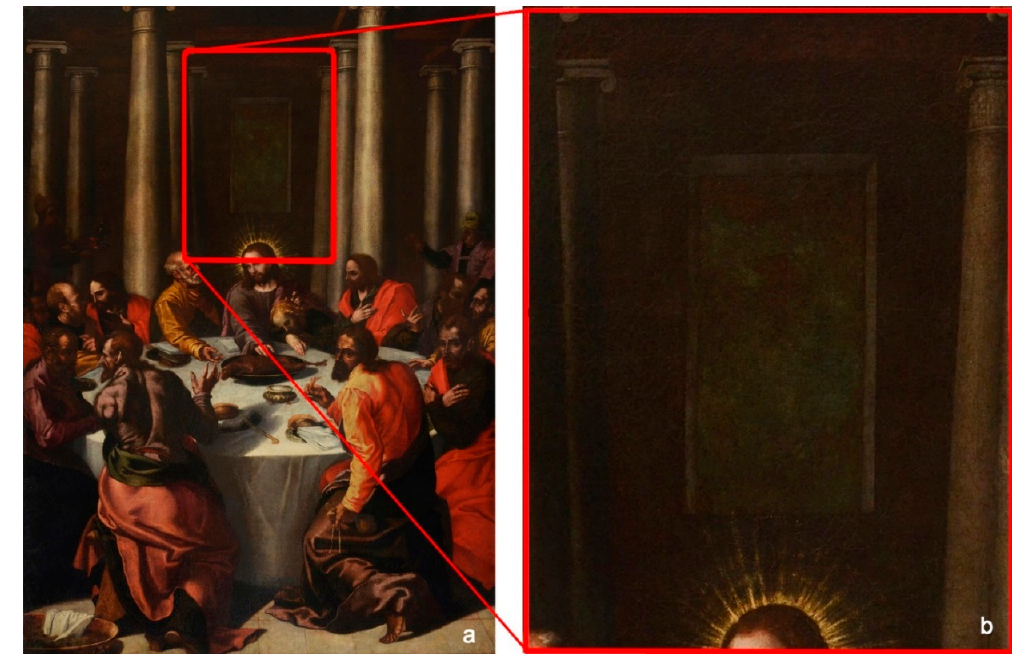
Figure 18. ( a ) G. Hovic, Last Supper; ( b ) particular punching.